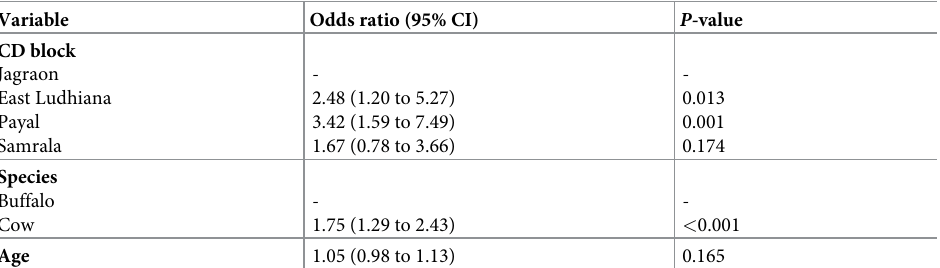
Table 5. Individual livestock multivariate GLMM for associations between individual level variables and cattle testing seropositive using logistic regression with village and farm included as a random effect.